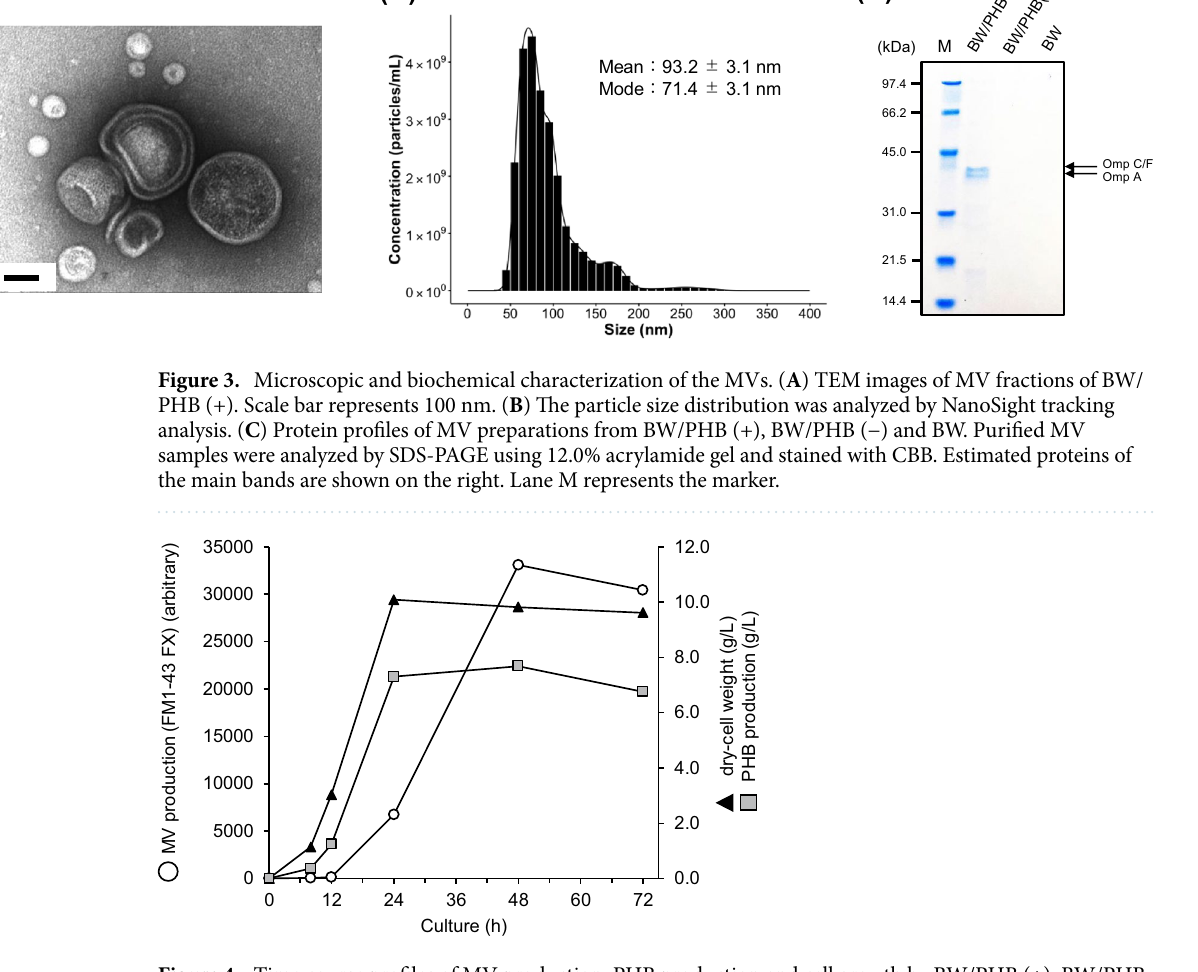
Figure 4. Time course profiles of MV production, PHB production and cell growth by BW/PHB (+). BW/PHB (+) was cultivated in LB medium containing 2.0% glucose at 30 °C for 72